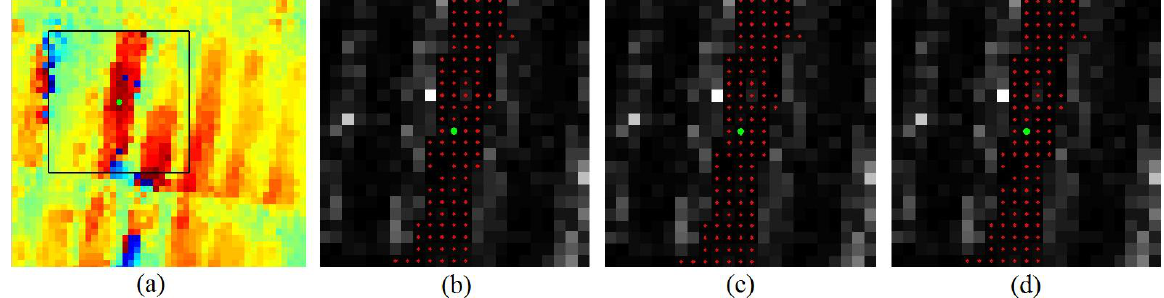
Fig. 1. Identification results of statistically homogenous pixels (SHP) (in red) for the green pixel with a detection window of 23×23 pixels by goodness-of-fit test. (a) is 1×5 multilooked interferogram enclosed in black rectangle, (b) is a zoom-in of the black